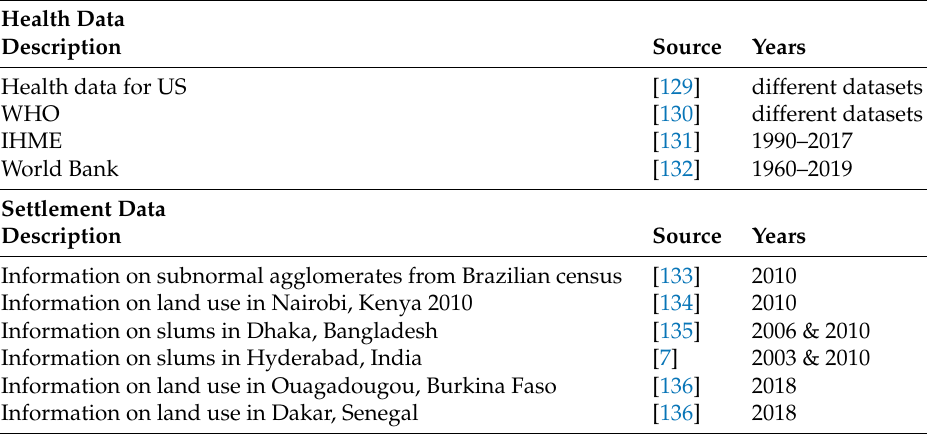
Table A3. Examples for health and settlement